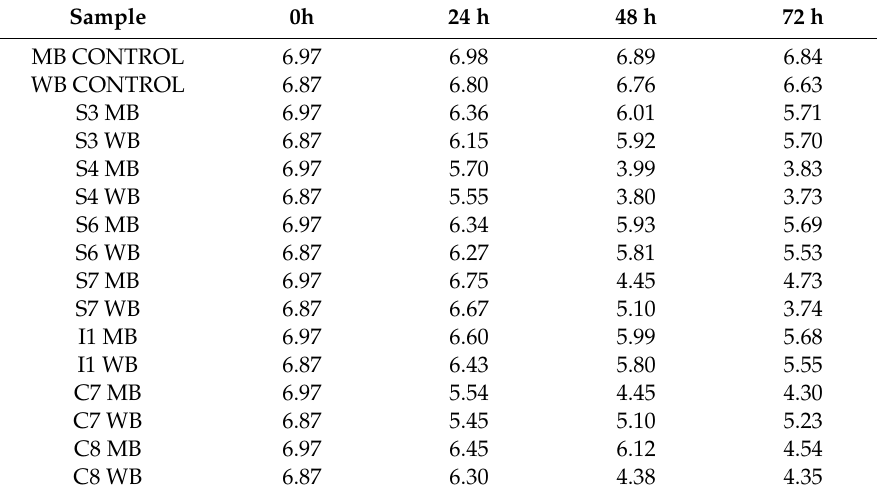
Table 1. pH results during fermentation.